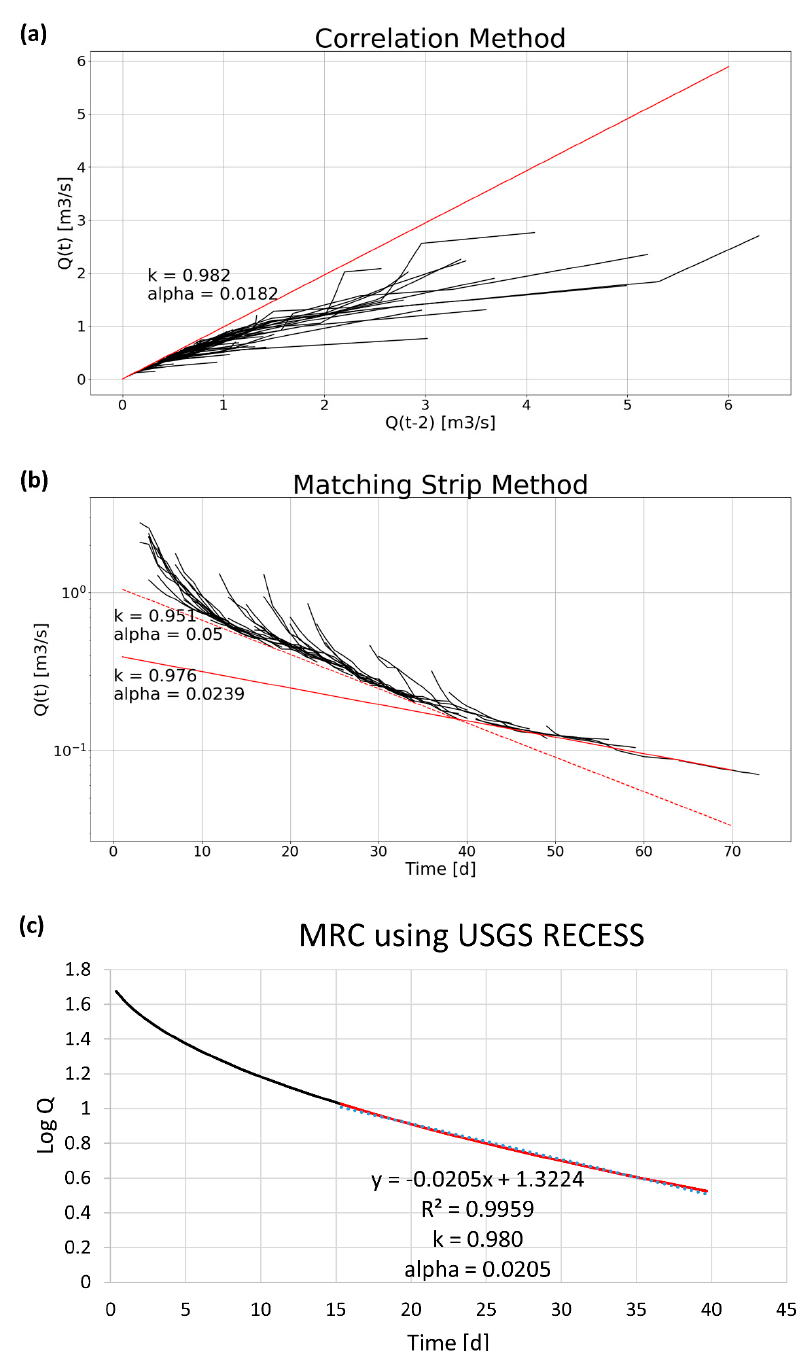
Figure 3. Master recession curves (MRCs) constructed via ( a ) correlation method; ( b ) matching strip method and ( c ) USGS RECESS. Recessions extracted from daily flow data from the Hessian Agency for Nature Conservation, Environment and Geology (HLNUG)